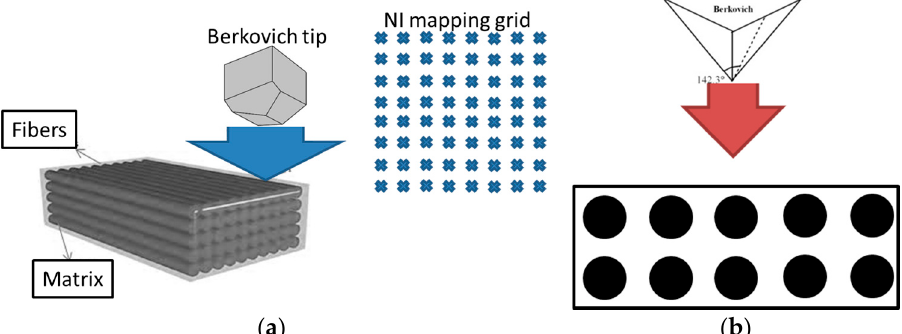
Figure 2. Nanoindentation schematic representation of mapping grid measurements ( a ); the indentation occurs at epoxy surface (matrix) ( b ), while the affection of the fibres (and, thus, their interface) underneath is revealed through the variation in resistance to an applied load and load ‐ unload curve form.